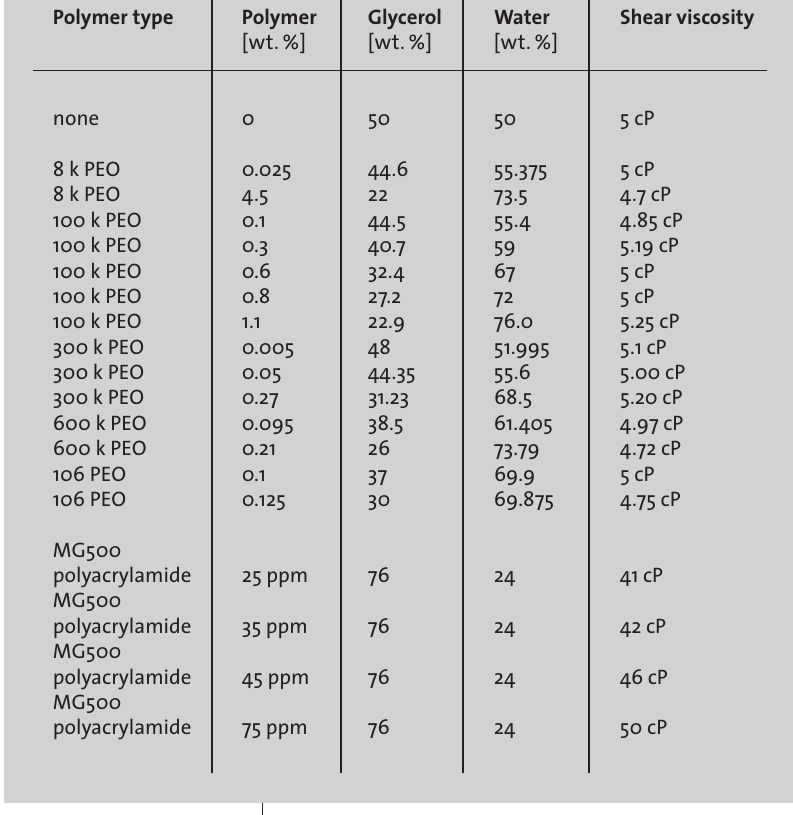
Table 1: A listing of the low and constant viscosity polymer solutions produced with polyethylene oxide and polyacrylamide